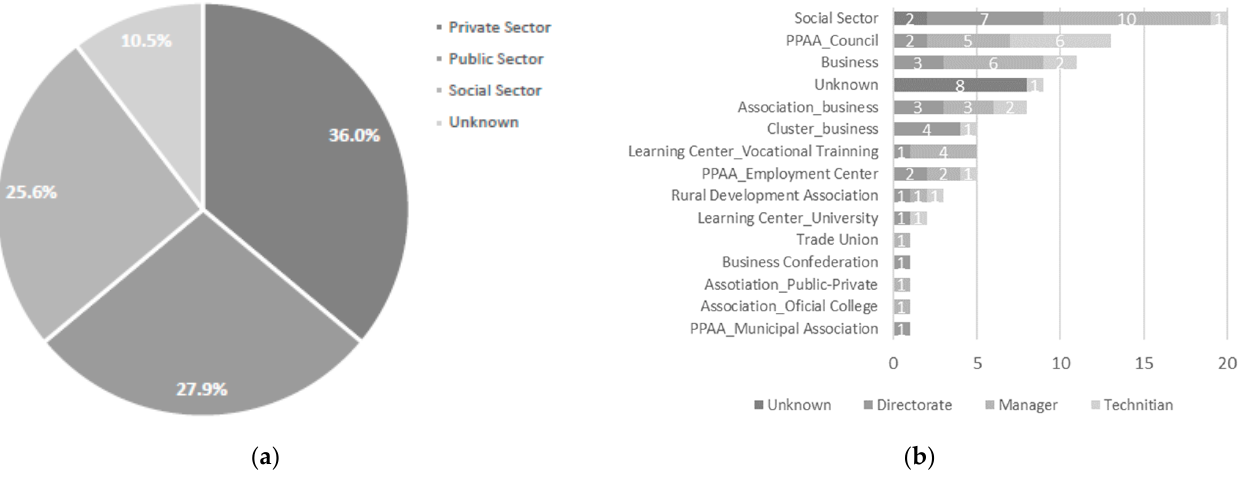
Figure 2. Survey process sample ( a ) distribution of the responses received according to the typology of the entity; ( b ) distribution of the responses received according to the position of the respondent.